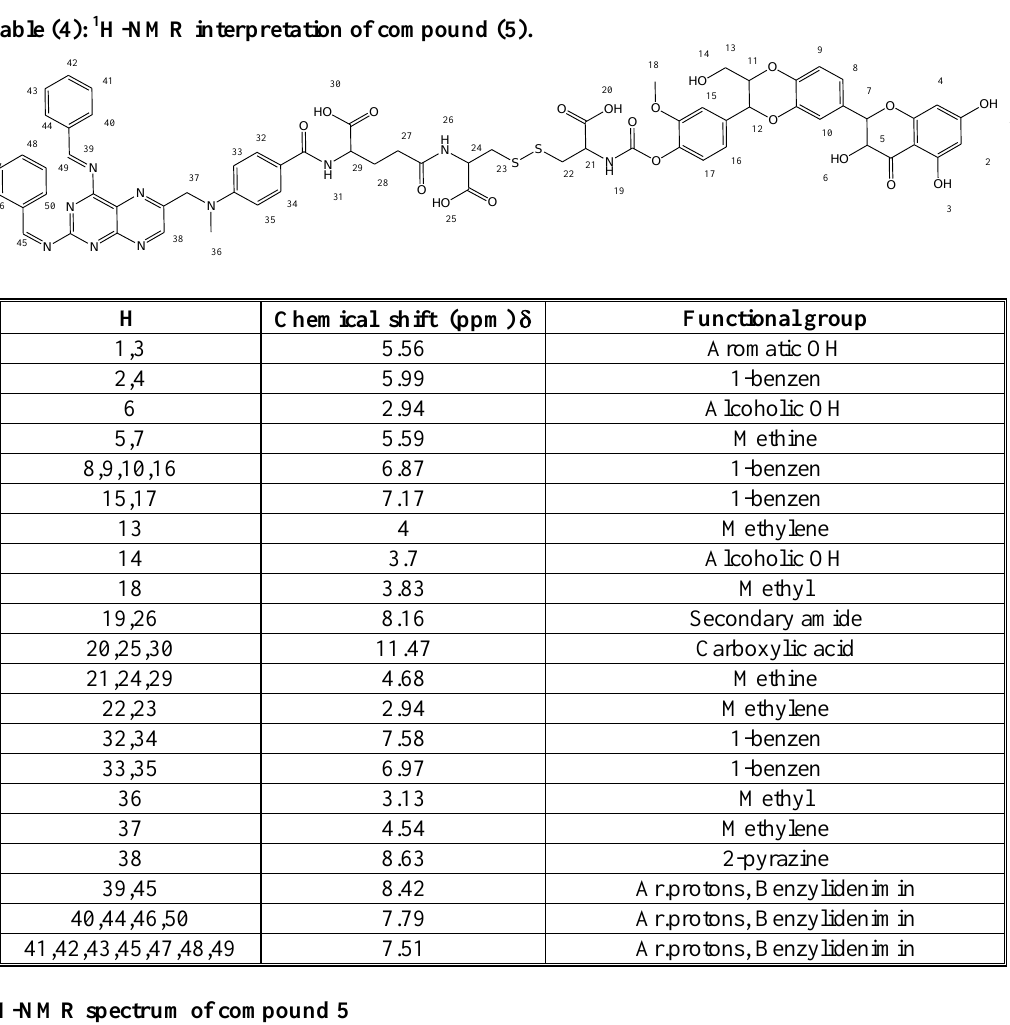
Table (4): 1 H-NMR interpretation of compound